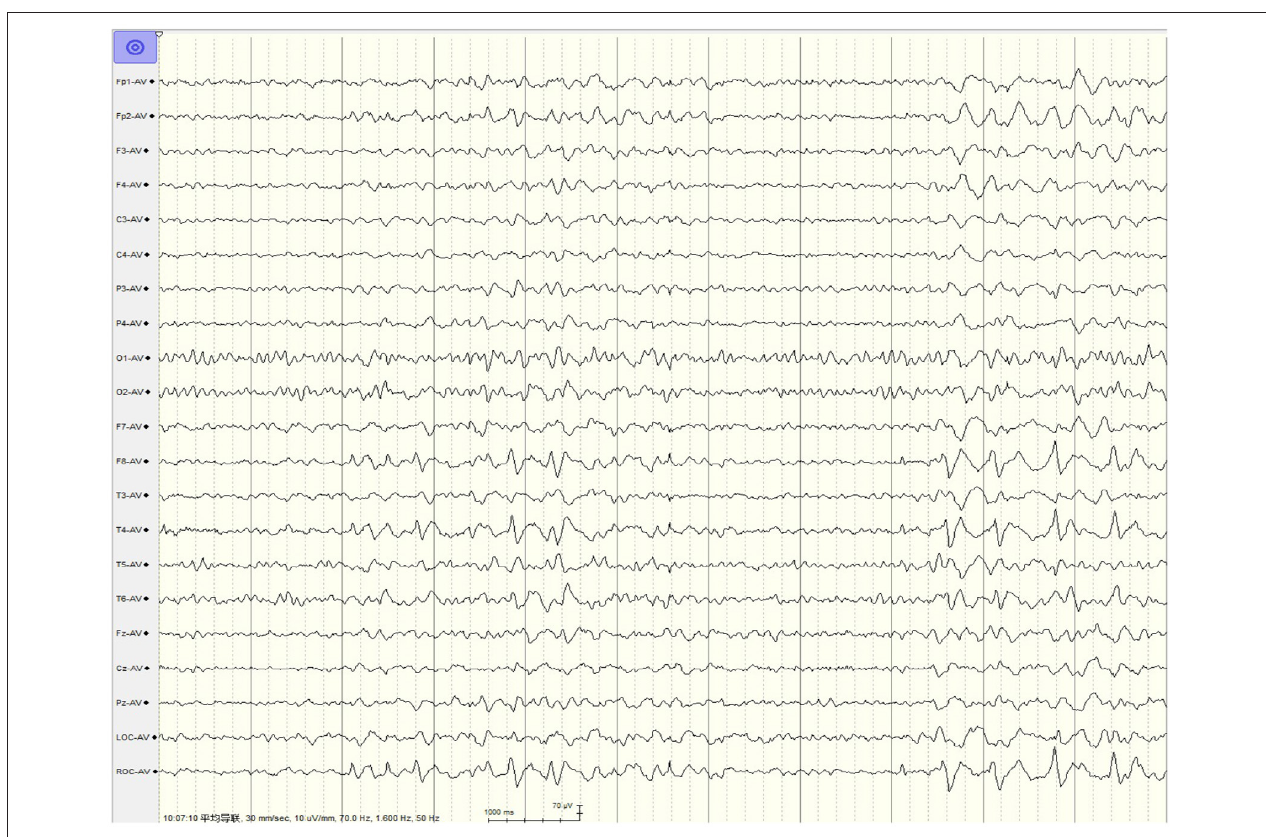
FIGURE 1 | EEG in a 37-year-old male patient with neurosyphilis. LPDs were predominant in the right temporal region, appearing at a 1.5-Hz